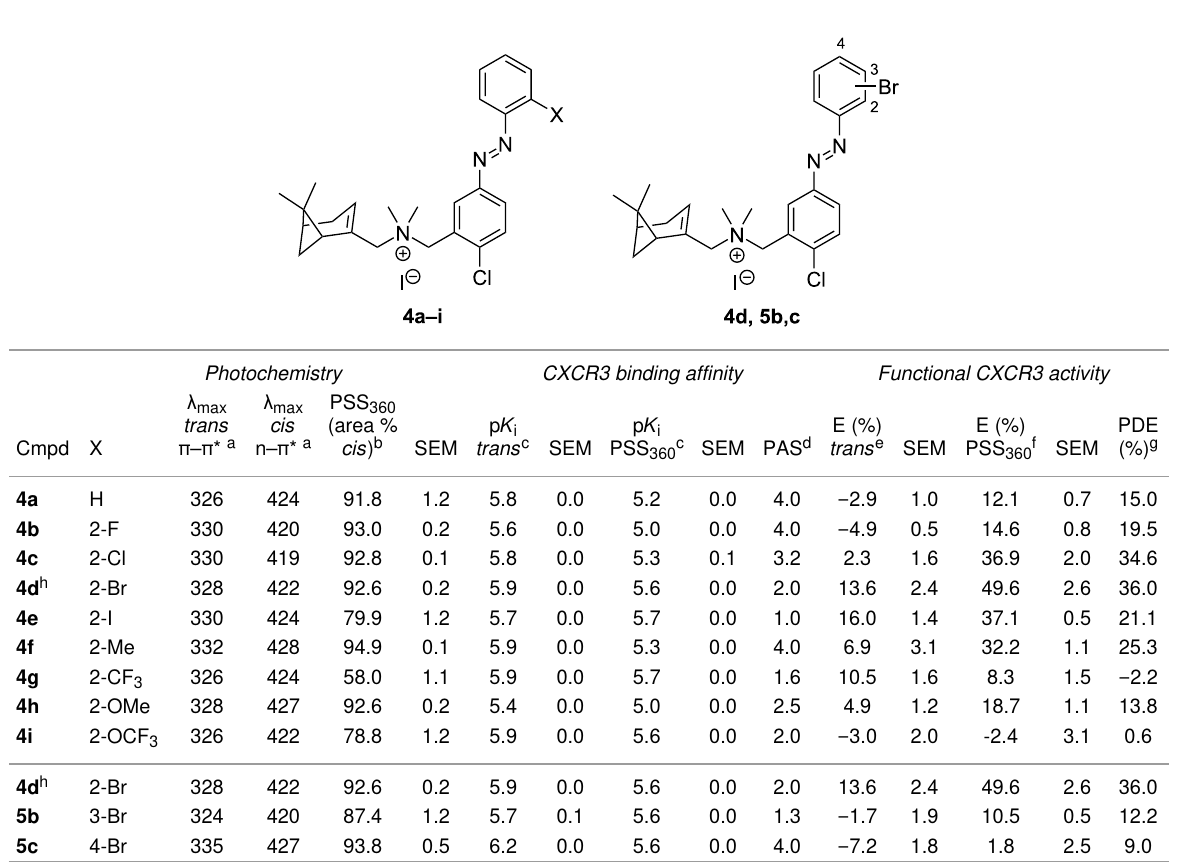
Table 2: Structure and results of photochemical, binding and functional characterization of compounds 4a–i and 5b , c .